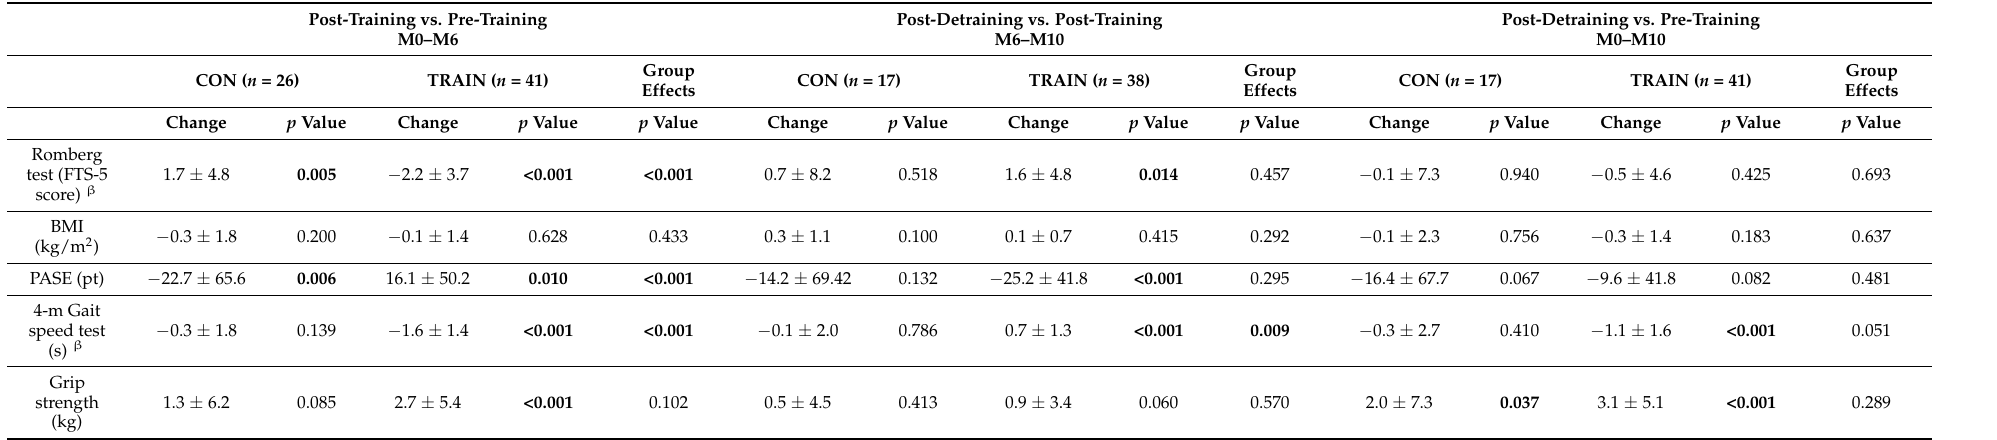
Table 5. Changes in FTS-5 tests between and within groups in different evaluation